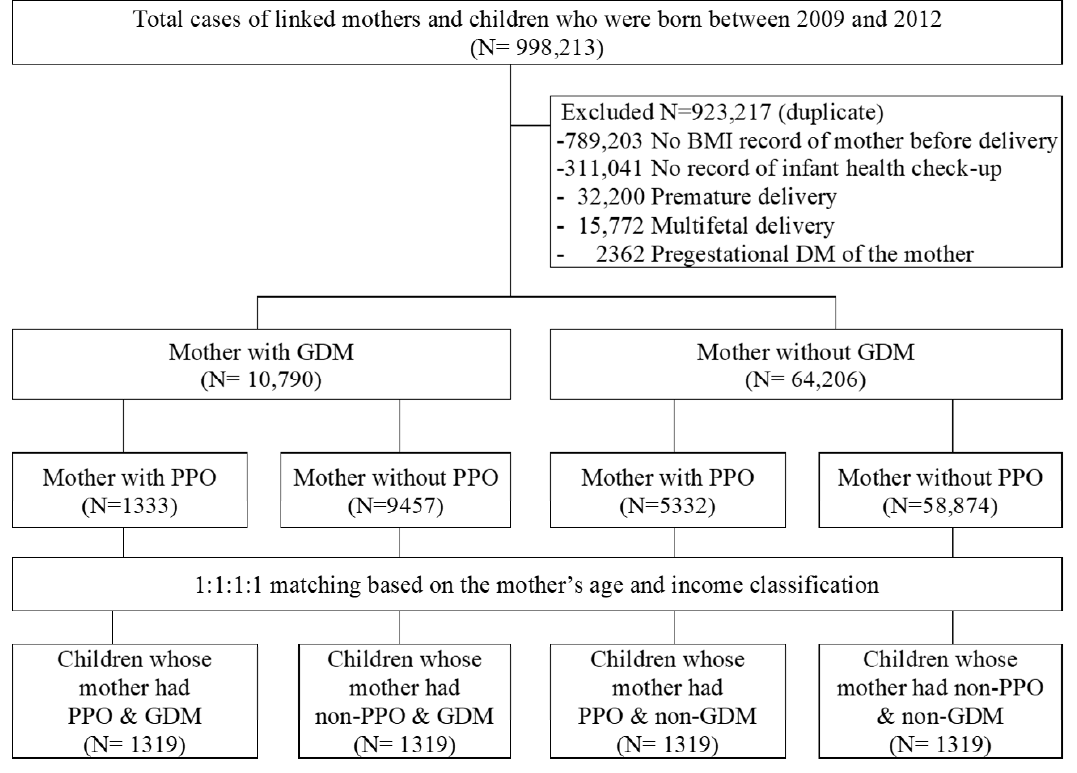
Figure 1. Diagrammatic representation of selection and classification of participants. BMI: body mass index, DM: diabetes mellitus, GDM: gestational diabetes mellitus, PPO: pre-pregnancy obesity. Children’s BMI percentile, sex, birth weight, breastfeeding, diet, television (TV)